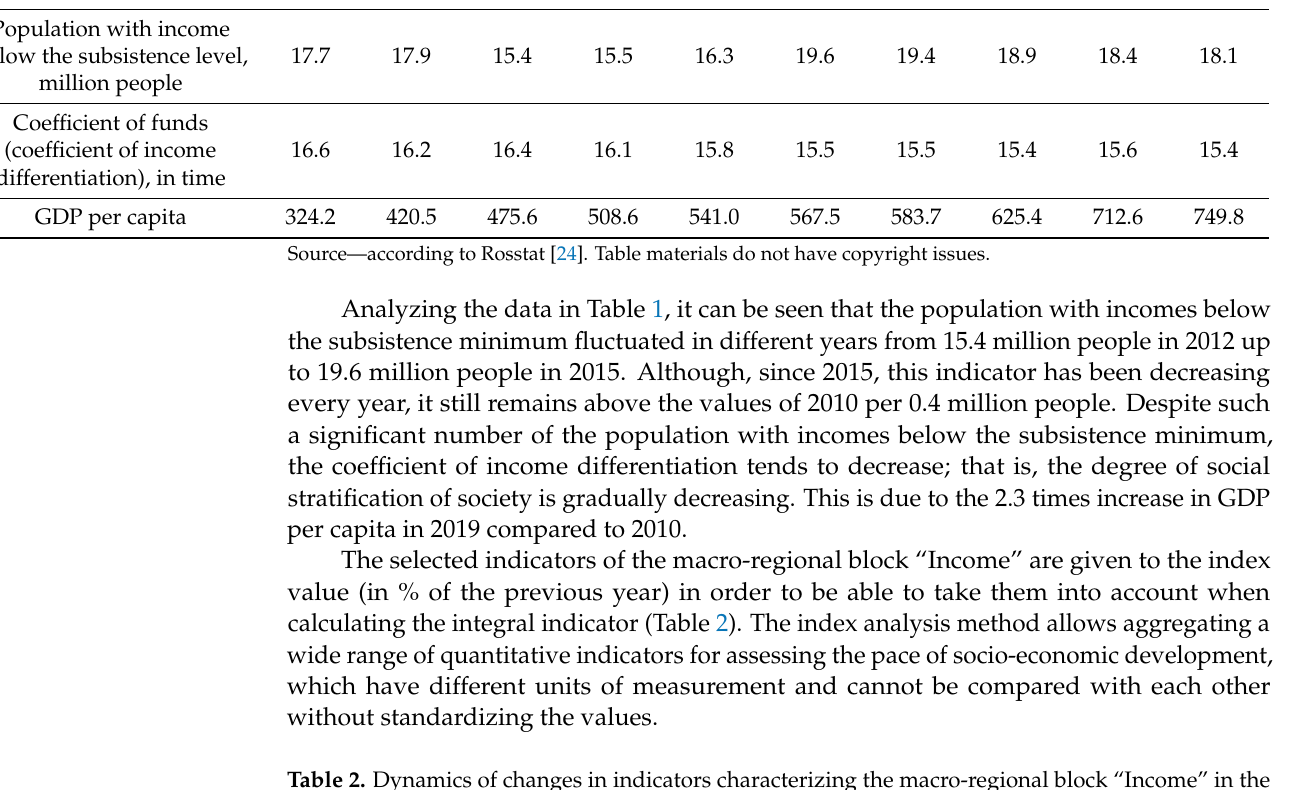
Table 2. Dynamics of changes in indicators characterizing the macro-regional block “Income” in the Russian Federation in 2010–2019, in % of the previous